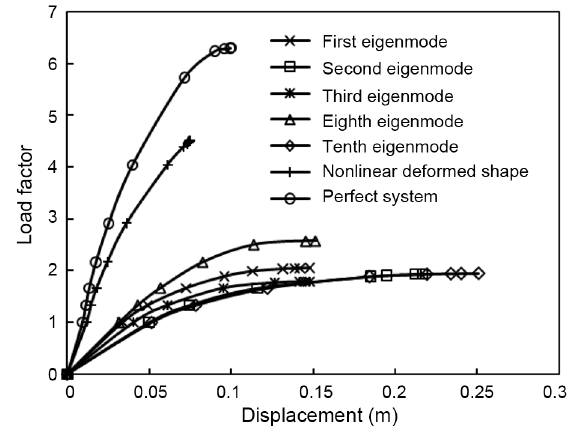
Fig. 10. Load-displacement curves for imperfect structures, loading case g + s/2